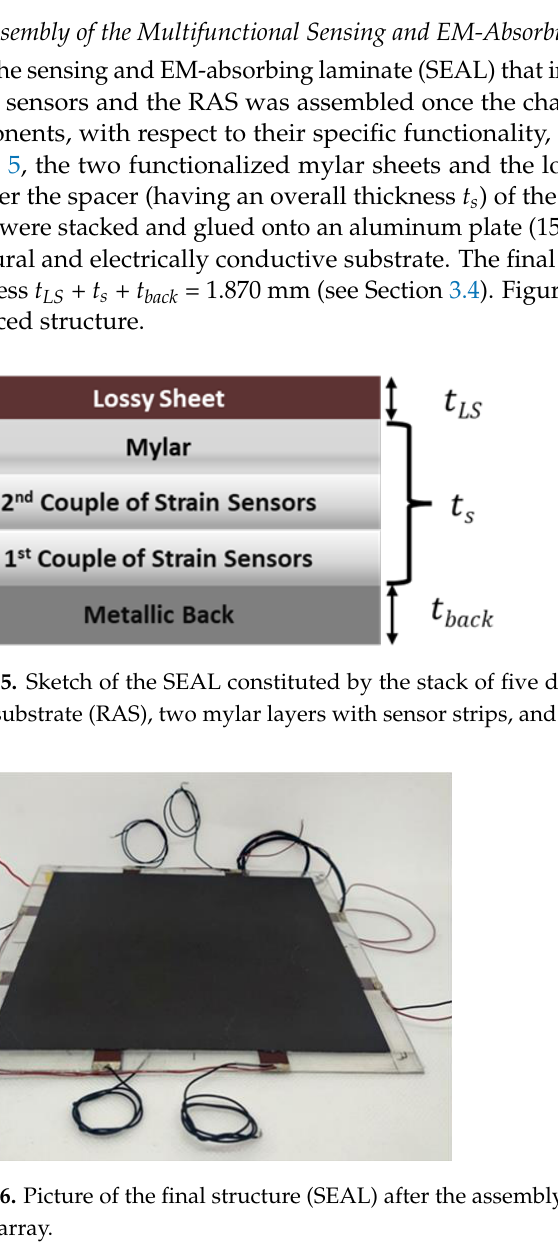
Figure 4. Picture of the grid constituted by the two orthogonal couples of piezoresistive sensors on an aluminum plate.